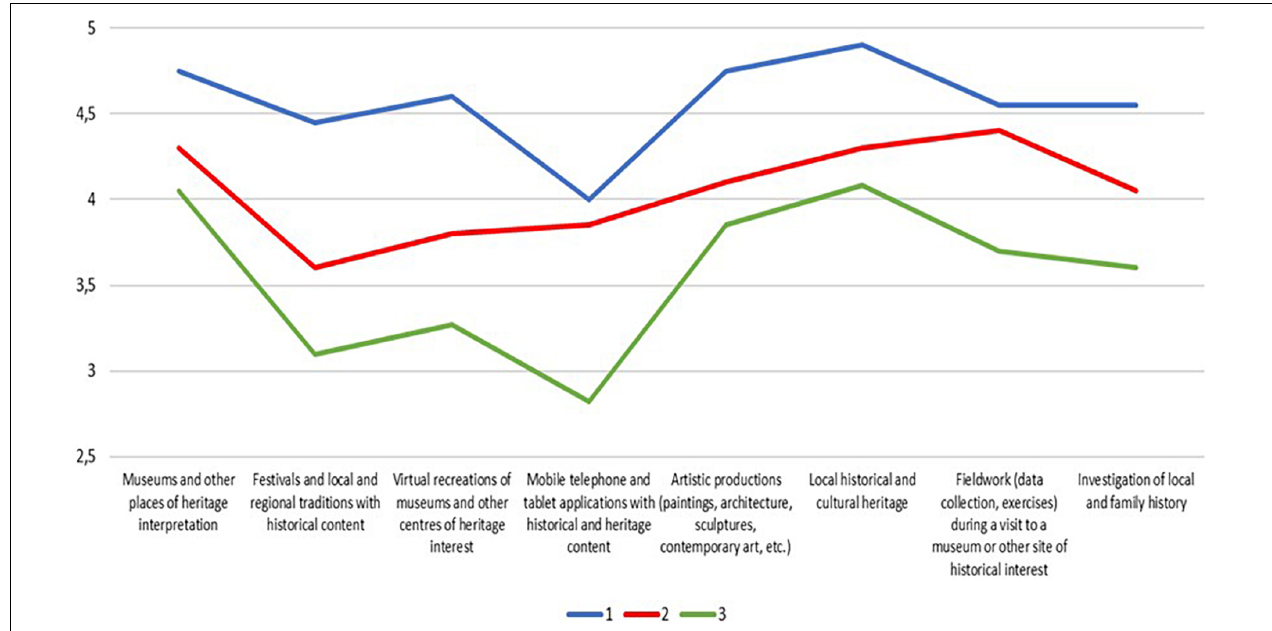
with factor 2, while being grouped preferentially with resources such as films, documentaries and videogames. Also in factor 2, in addition to resources linked with the mass media, more